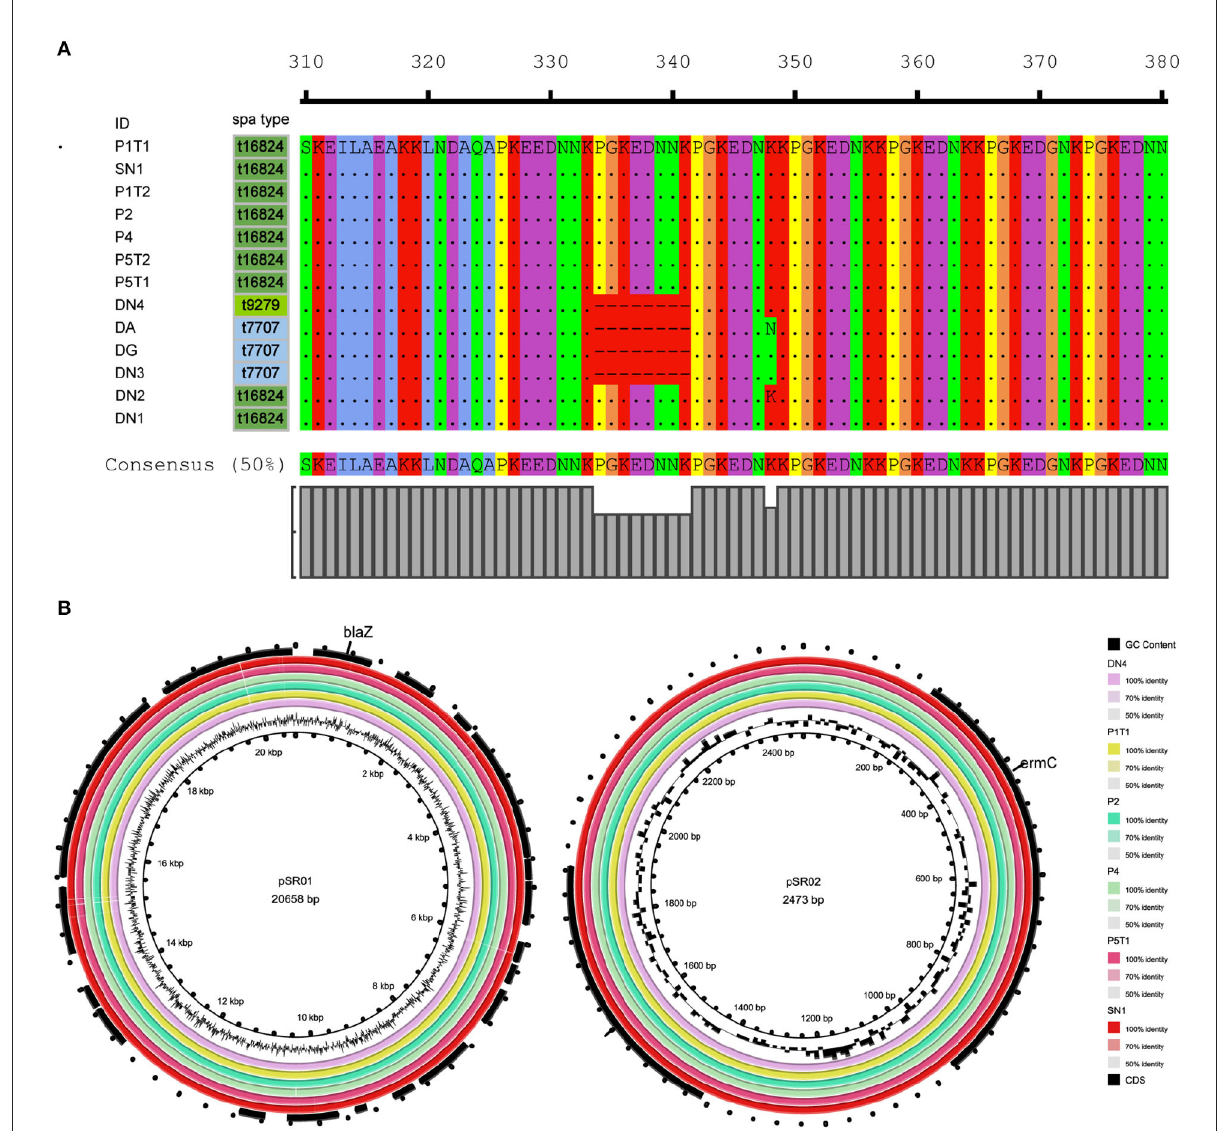
FIGURE3 Molecular characteristics of ST88-methicillin-resistant Staphylococcus aureus (MRSA) isolates detected in this ward. (A) Amino acid sequence differences of protein A encoded by spa. (B) ST88-MRSA isolate plasmid features.